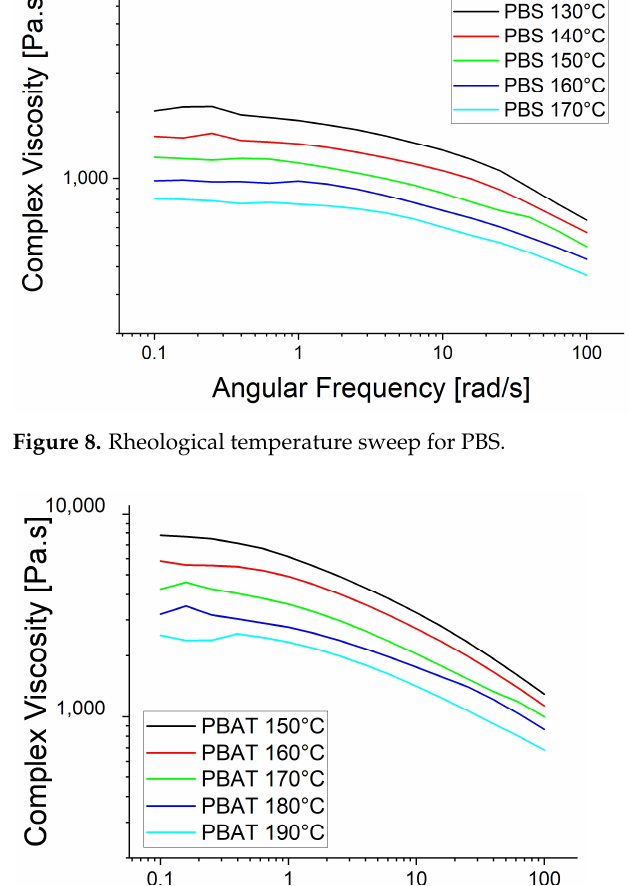
Figure 7. Rheological temperature sweep for PP.